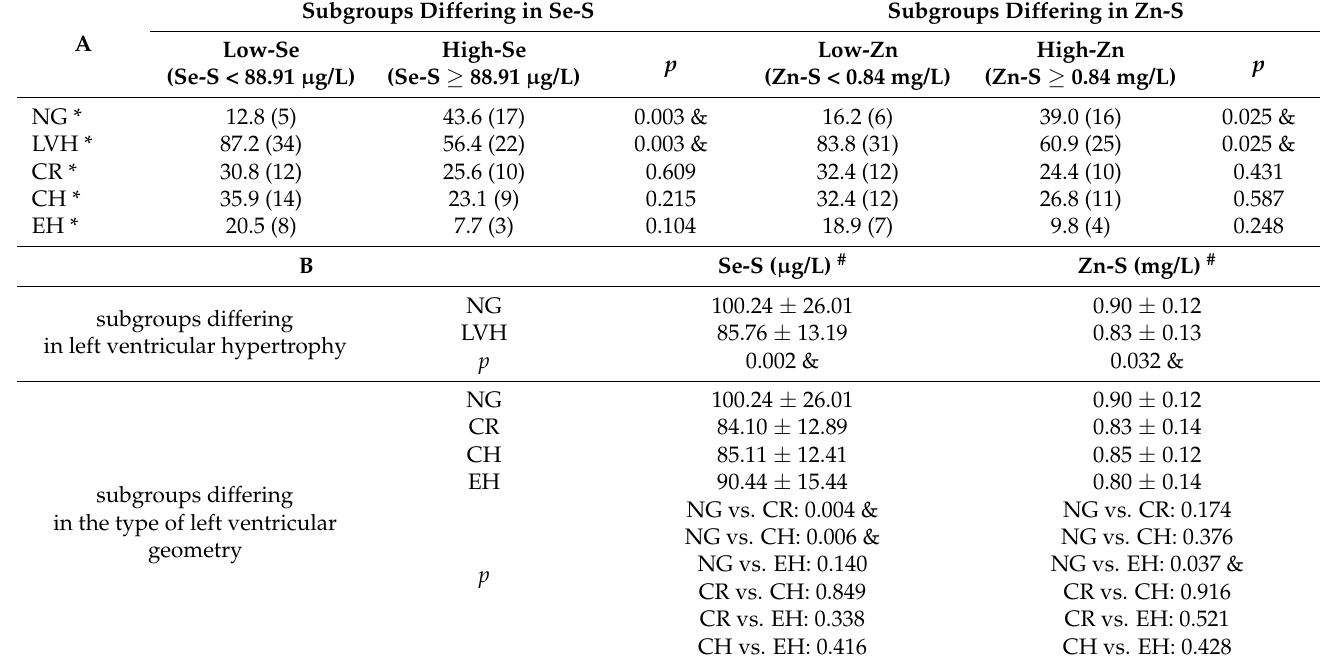
# mean ± standard deviation; * percentage (number); CH—concentric hypertrophy of the left ventricle; CR— concentric remodelling of the left ventricle; EF—ejection fraction of the left ventricle; EH—eccentric hypertrophy of the left ventricle; IVSDd—interventricular septum diastolic diameter; LVEDd—left ventricle end-diastolic diameter; LVESd—left ventricle end-systolic diameter; LVH—left ventricle hypertrophy; LVMI—left ventricle mass index; NG—normal geometry of the left ventricle; PWDd—posterior wall diastolic diameter; RWT—relative wall thickness. When comparing the patient subgroups divided by the median of the serum selenium concentration and the median of the serum zinc concentration, it was demonstrated that LVH was statistically significantly more frequent in patients with Se-S < median compared to patients with Se-S ≥ median (87.2% vs. 56.4%, p < 0.05), as well as in patients with Zn-S < median compared to patients with Zn-S ≥ median (83.8% vs. 60.9%, p < 0.05). Geometry and hypertrophy of the left ventricle in the subgroups with different serum selenium and zinc concentrations are presented in Table 4. Table 4. Geometry and hypertrophy of the left ventricle and serum selenium and zinc concentrations in the studied subgroups. ( A ) Geometry and hypertrophy of the left ventricle in the studied subgroups differ in serum selenium and zinc concentrations. ( B ) Serum selenium and zinc concentrations in the studied subgroups differ in geometry and left ventricular